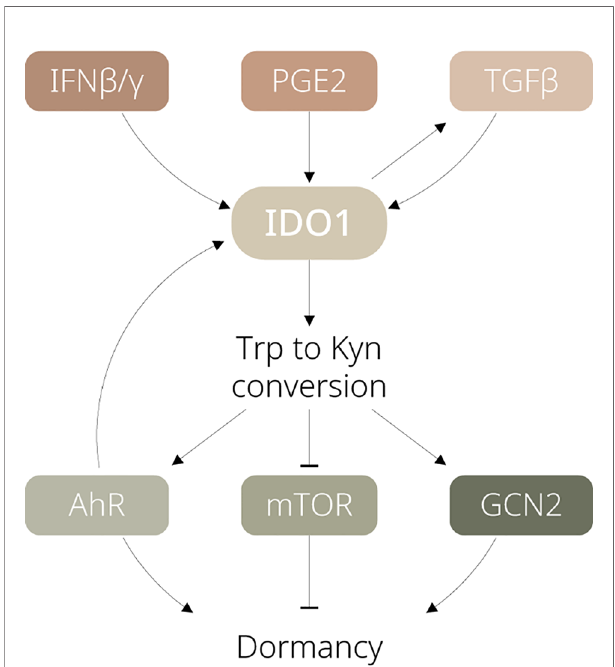
FIGURE 1 | Schematic diagram illustrating the signalling pathways involved in IDO1-dependent tumour dormancy. IFN, interferon; PGE2, prostaglandin E2; TGF, transforming growth factor; Trp, tryptophan; Kyn, kynurenine; AhR, aryl hydrocarbon receptor; mTOR, mammalian target of rapamycin; GCN2, general control nonderepressible